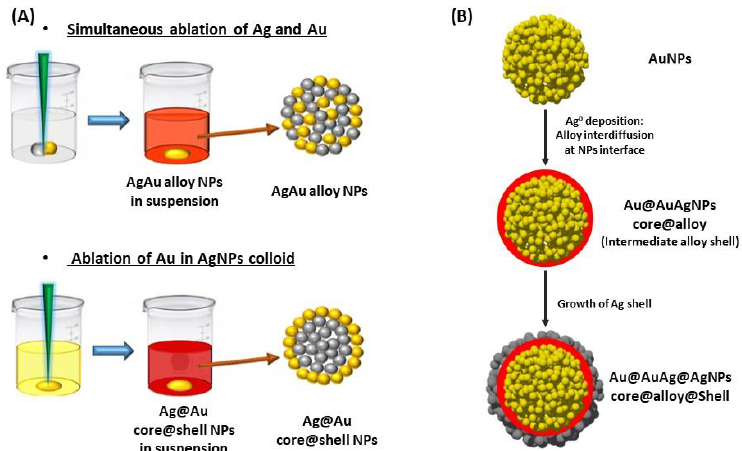
Figure 16. ( A ) Pulsed laser ablation in liquid: simultaneous ablation of Ag and Au to synthesize AgAuNPs and ablation of Au in AgNPs colloid to form core@shell structure (Au@AgNPs). Reproduced with permission from [145]. Copyright (2014,) Springer-Verlag Berlin Heidelberg. ( B ) Schematic illustration to form an intermediate AgAu alloy shell by interdiffusion at the NPs interface during hydrothermal treatment. Adapted from [148]. Copyright (2011), American Chemical Society.